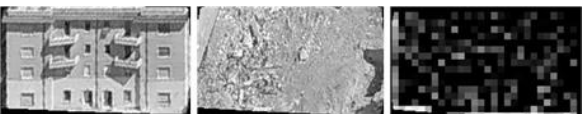
Figure 17. Total collapse example, rectified images on both epochs and correlation coefficient